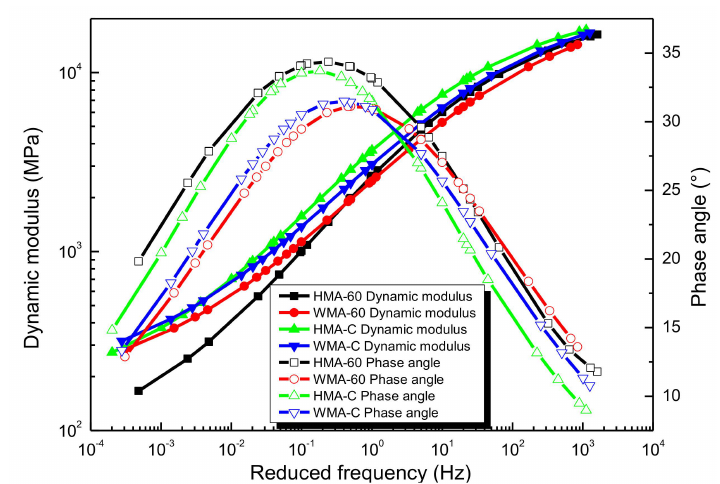
Figure 17. The Wicket diagram of the asphalt mixture.